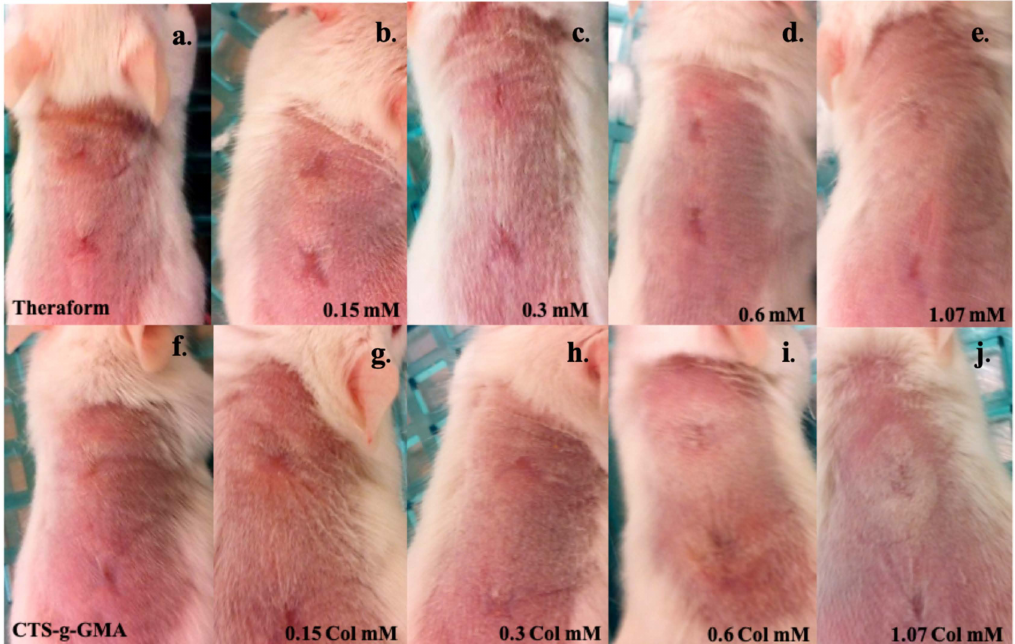
Figure 11. Skin recovery after 40 days of treatment with ( a ) TheraForm ® ; ( b ) CTS-g-GMA; (CTS-g- GMA)-AuNPs at different concentrations: ( c ) 0.15 mM, ( d ) 0.3 mM, ( e ) 0.6 mM, ( f ) 1.07 mM; and ((CTS-g-GMA)-AuNPs)-Col at different concentrations: ( g ) 0.15 mM, ( h ) 0.3 mM, ( i ) 0.6 mM, ( j ) 1.07 mM.